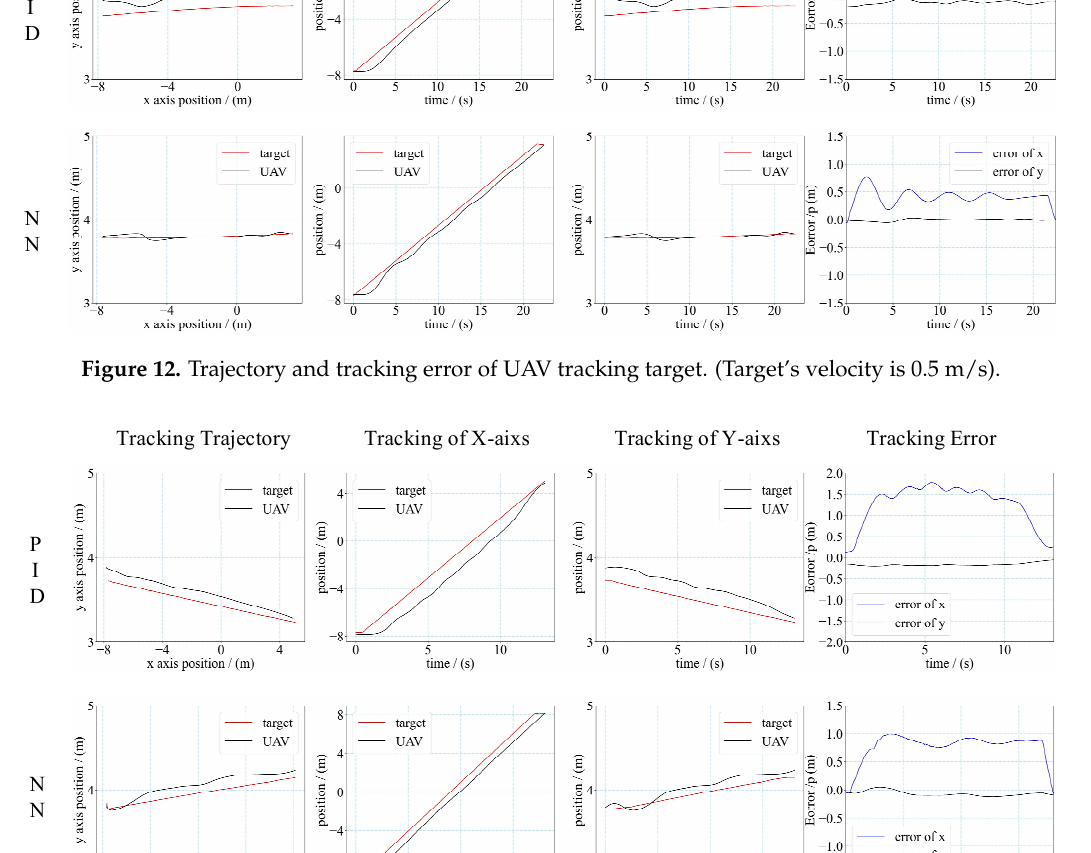
Figure 14. Trajectory and tracking error of UAV tracking target. (Target’s velocity is 1.2 m/s).